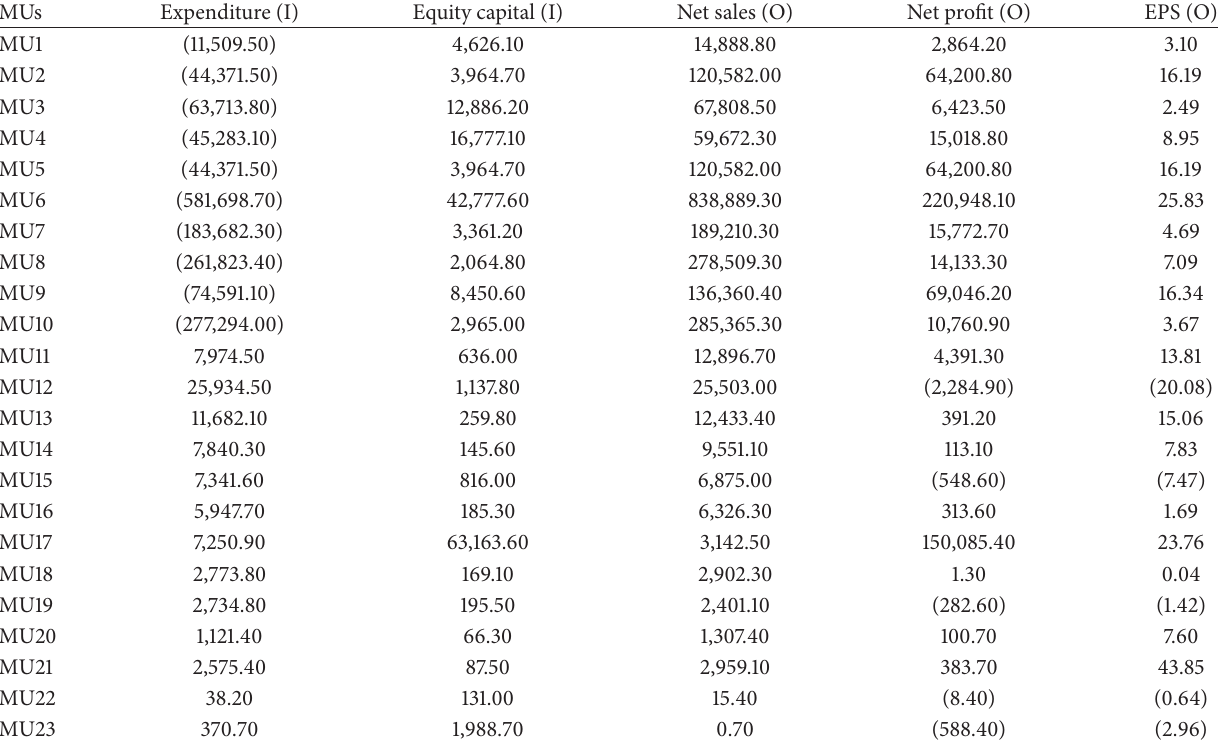
Table 2: Financial results of Indian mining companies in 2014 (Rs. million; except